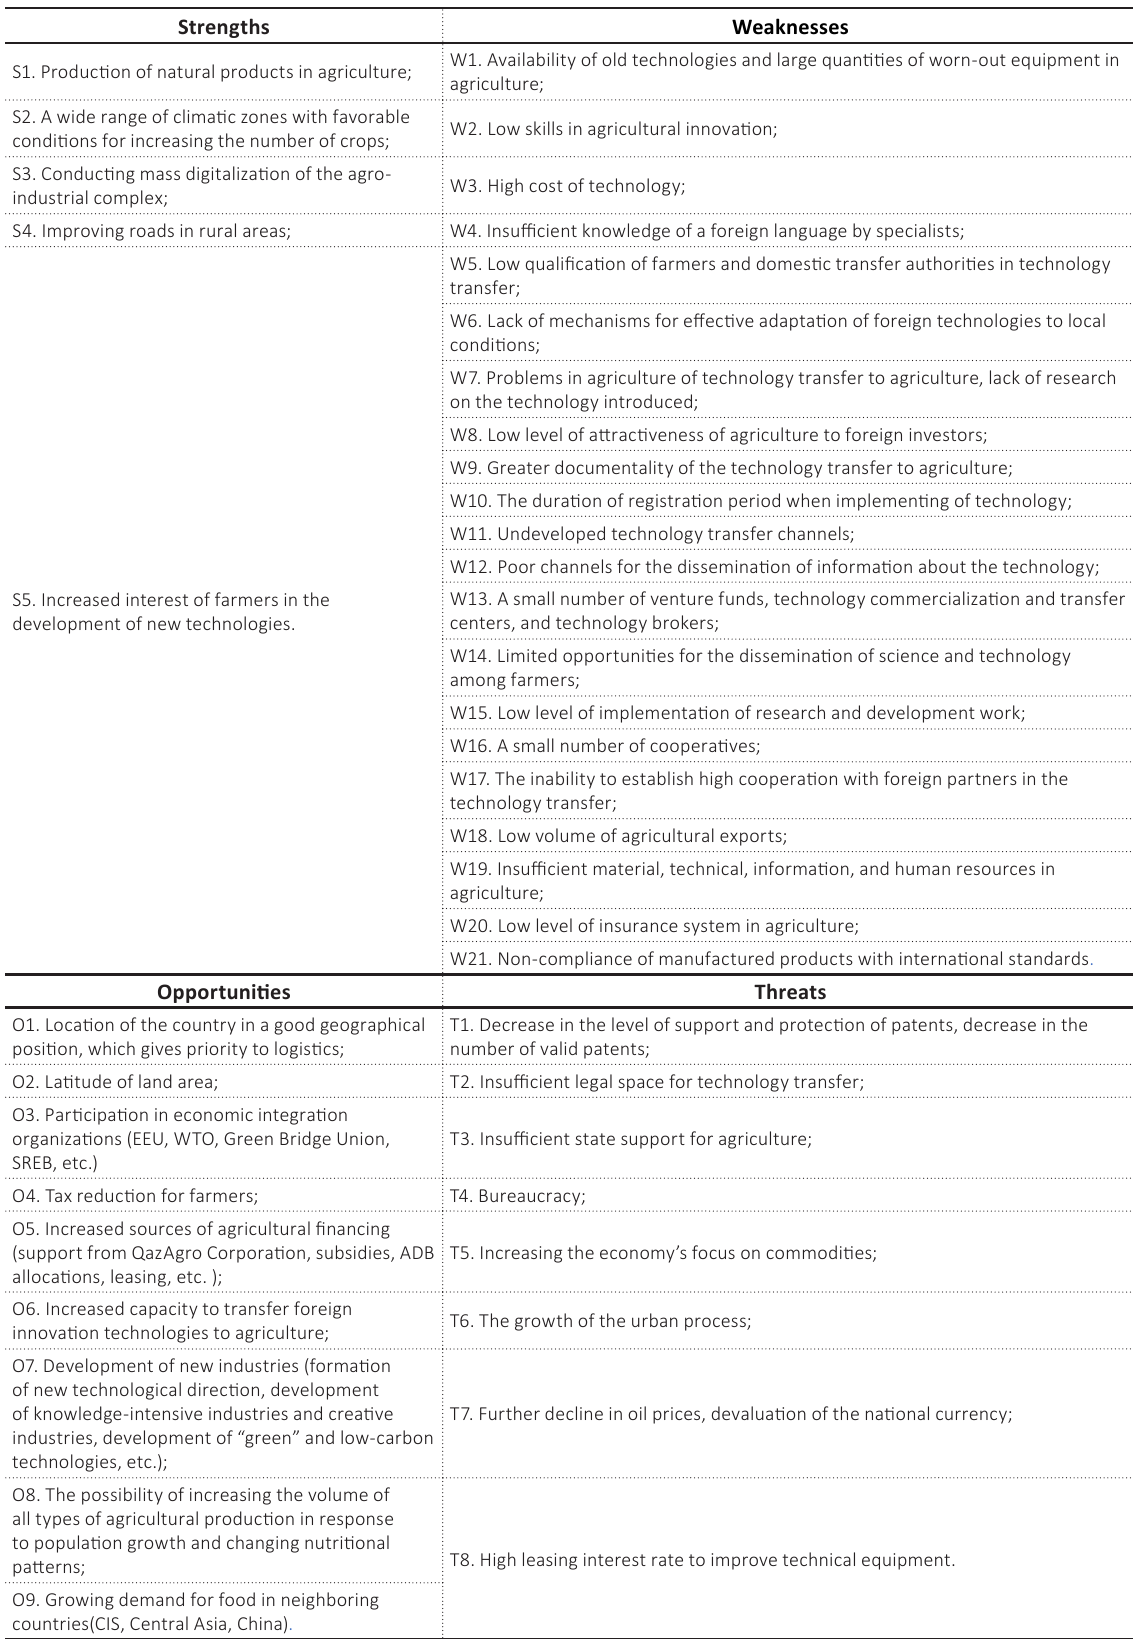
Table 3. SWOT analysis of technology transfer to the agricultural sector of Kazakhstan